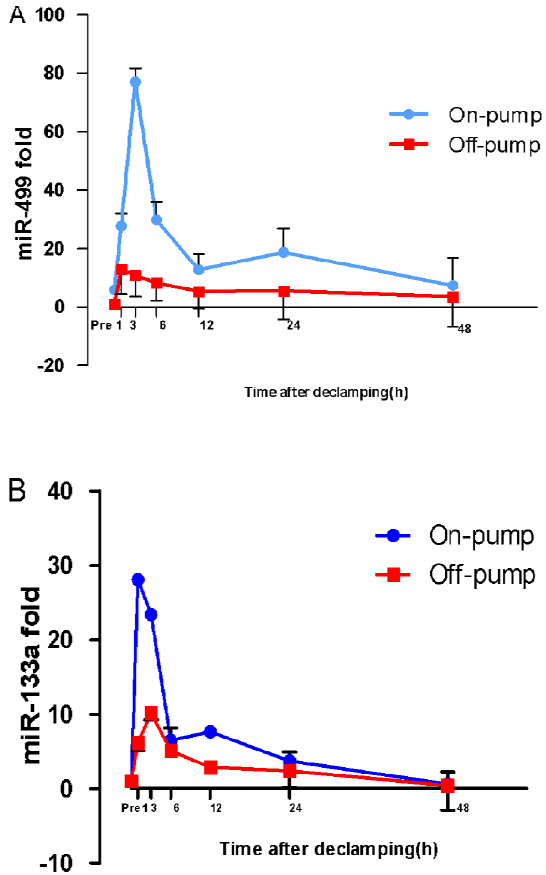
Figure 3. Pump-on and pump-off differences in miR-499 (Figure 3A) and miR-133a (Figure 3B) concentrations. The two curves differ significantly (p , 0.0001) for both miR-499 and mIR-133a. In the arrested heart (on-pump) group versus the beating heart (off- pump) group, the miR-499 concentrations were significantly higher at post-declamping hours 1, 3, 6, 12, and 24 (p , 0.0001), while the miR- 133a concentrations were significantly higher at hours 1, 3, and 12 (p , 0.0001). All mean 6 standard deviation levels are expressed as fold increase (2 2 DD Ct scale) relative to those in the preoperative control.